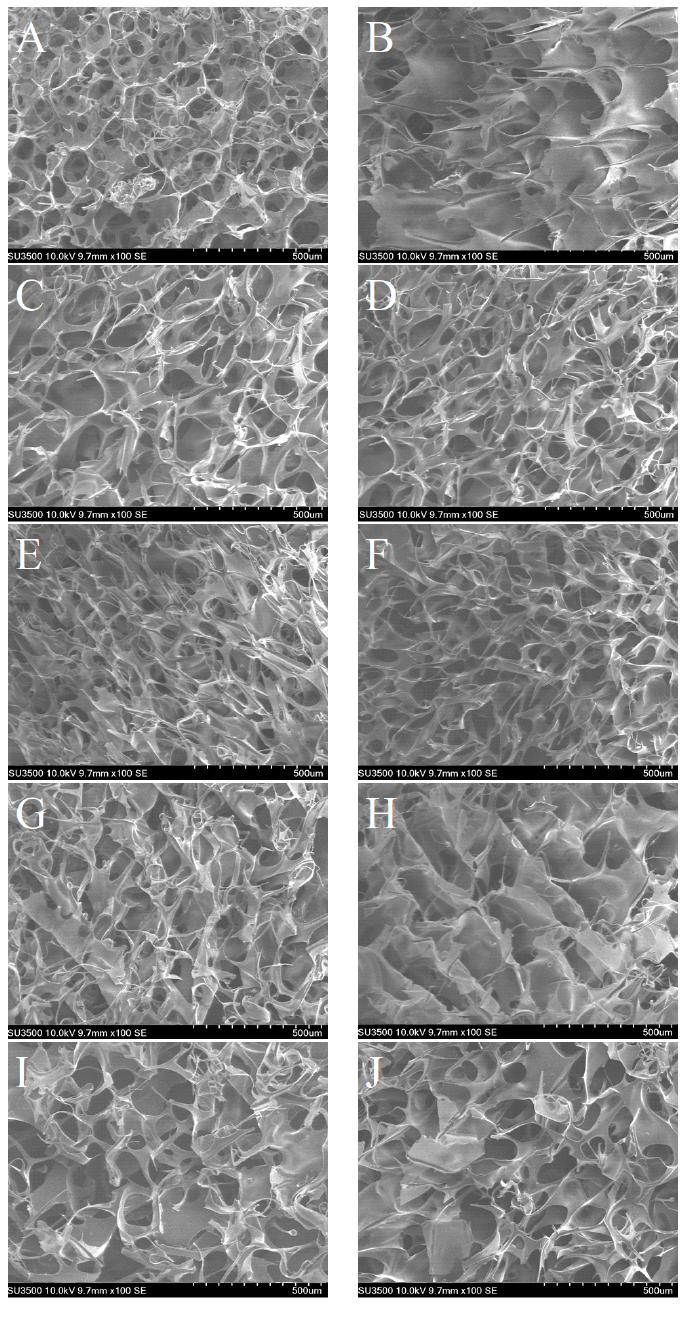
Figure 7. SEM images of the low methoxyl pectin/sodium caseinate (LMP/CAS) complex. ( A ) represent LMP/CAS complexes. ( B – D ) represent LMP/CAS complexes with the addition of 5, 15, and 30 mM Na + , respectively. ( E – G ) represent LMP/CAS complexes with the addition of 5, 15, and 30 mM K + , respectively. ( H – J ) represent LMP/CAS complexes with the addition of 5, 15, and 30 mM Ca 2+ , respectively.